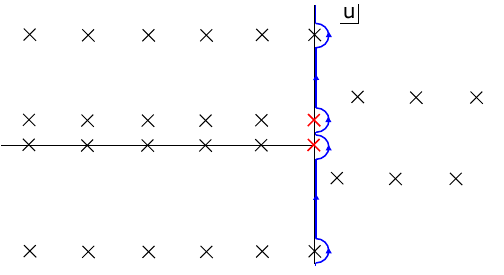
Figure 3 . Contour followed in the integral. Deforming to the right gives two 4 F 3 functions or the Wilson function. Deforming to the left is more suitable to deduce that as M ! 1 only 2 poles dominate (colored in